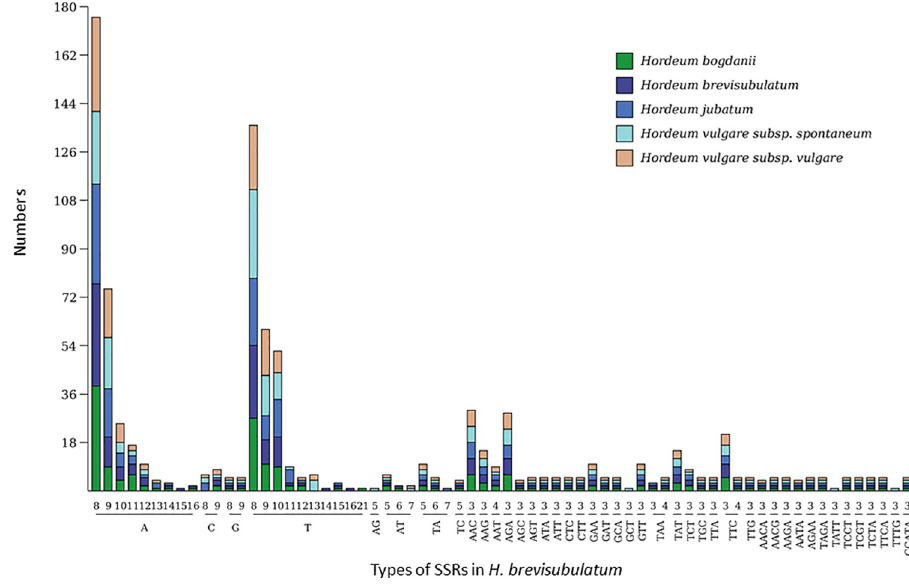
Fig 3. Statistical information of SSRs in H . brevisubulatum